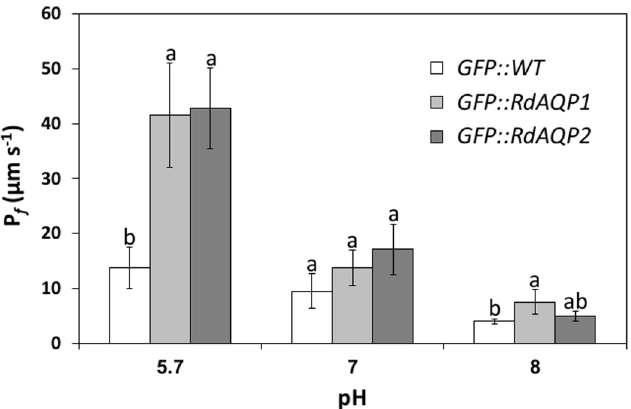
Fig 6. The effect of pH on Rhizopus delemar aquaporin (AQP) water permeability. The protoplast osmotic water permeability coefficient ( P f ) determined in Arabidopsis thaliana protoplasts transiently expressing GFP::AQP (GFP, green fluorescent protein) and in control protoplasts transiently expressing GFP. Values are means ± SE (n = 15). Different lowercase letters above the bars denote significant differences for each pH level in each transformed gene ( P <